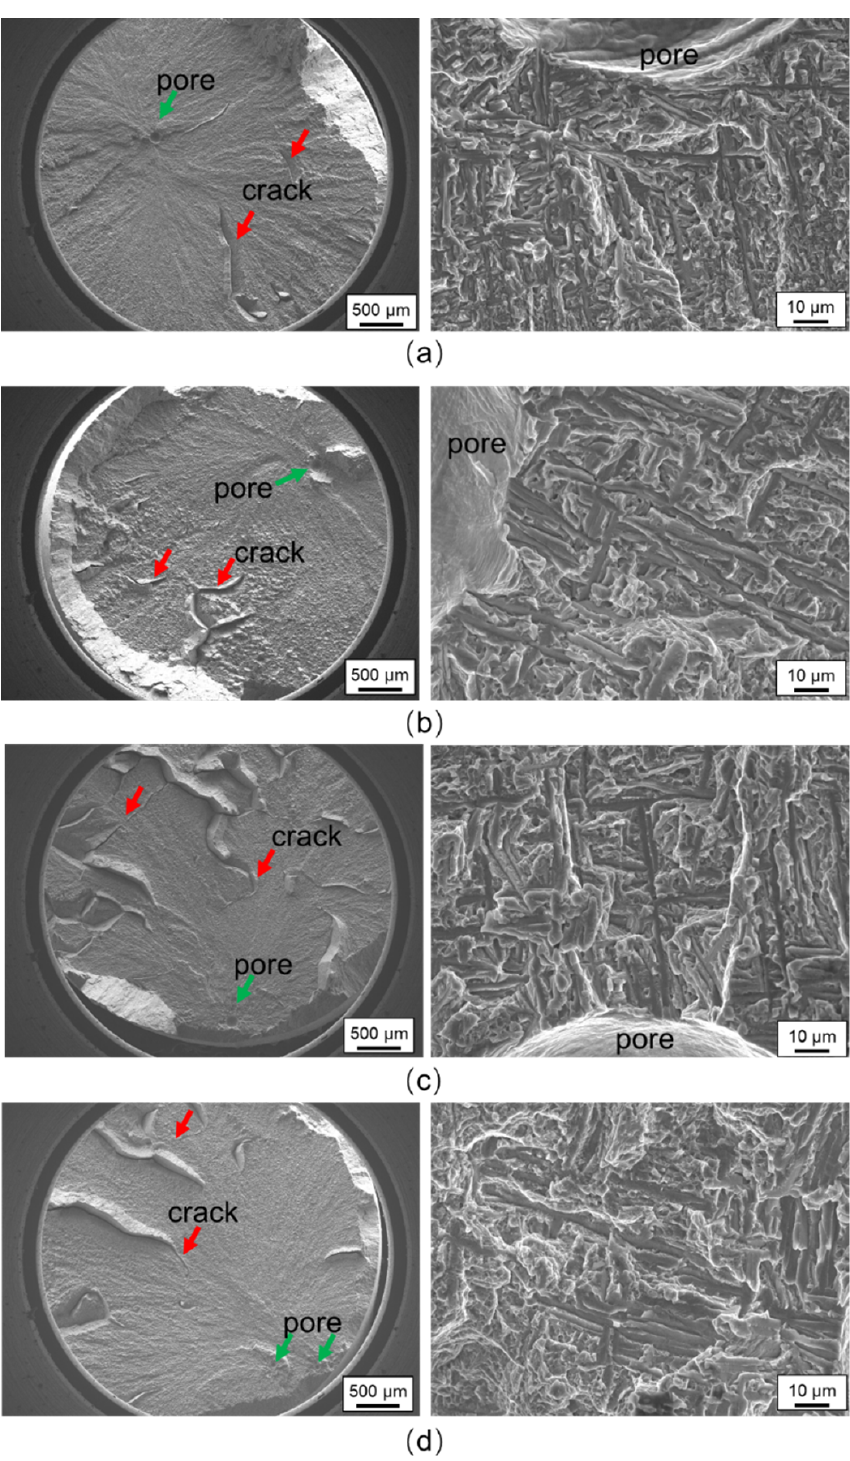
Figure 6. Fracture surfaces of the samples tested at room temperature: ( a ) annealed, ( b ) ST, ( c ) STA1, and ( d )